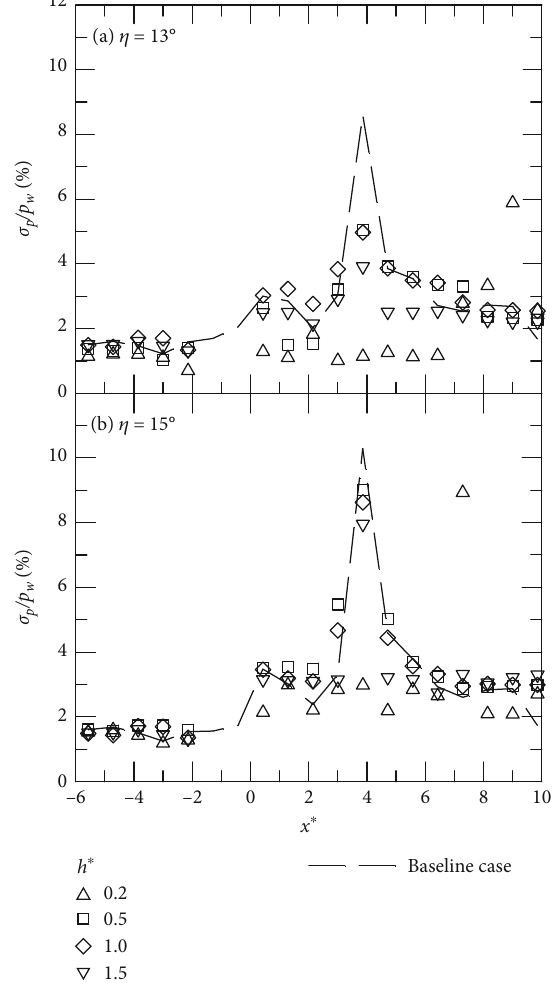
Figure 8: Distribution of surface pressure fl uctuations for M = 0 : 89 .